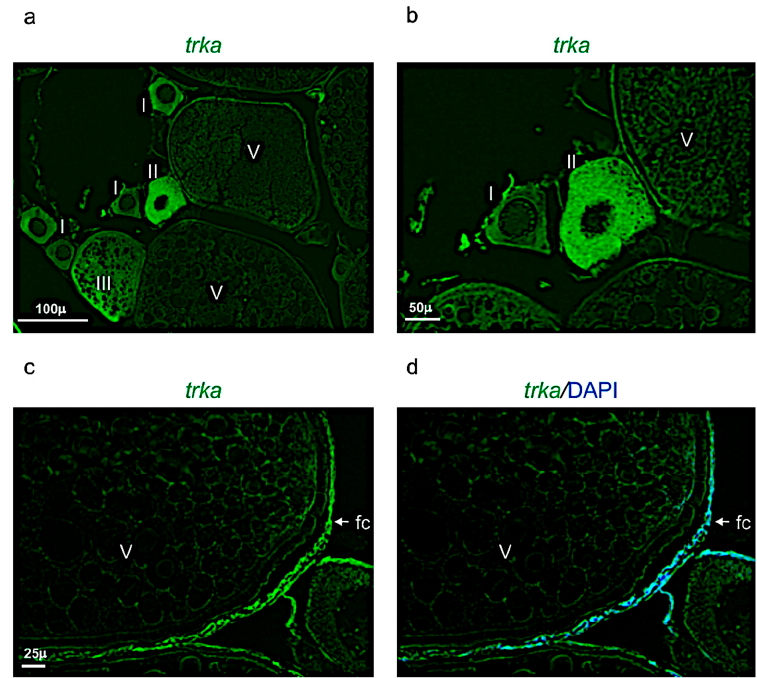
Figure 8. Trka expression pattern in adult zebrafish ovary. ( a ) Fluorescence in situ hybridization of trka in adult zebrafish ovary, mainly expressed in oocytes at different stages: II, III, and in follicular cells of stage V. ( b ) Fluorescence in situ hybridization of trka in oocytes at the stages I, II, and V. ( c ) Fluorescence in situ hybridization of trka, high magnification of follicular cells in oocyte at stage V. ( d ) Fluorescence in situ hybridization of ngf and cell nuclei (DAPI) , high magnification of follicular cells in oocyte at stage V. Scale bars: 100 µ ( a ); 50 µ ( b ); and 25 µ ( c , d ).